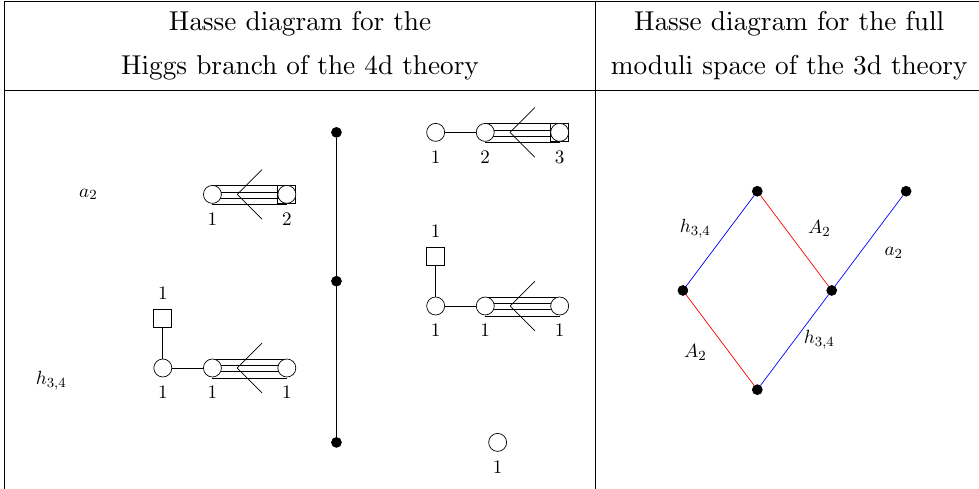
Table 8 . A 1 U 1 theory. Left : Hasse diagram for the Higgs branch of the 4 d (cid:2) theory. To the right of the Hasse diagram are the magnetic quivers for the closures of the leaves and to the left are magnetic quivers for the slices. Right : Hasse diagram for the full moduli space of the theory in 3 d = 4. N